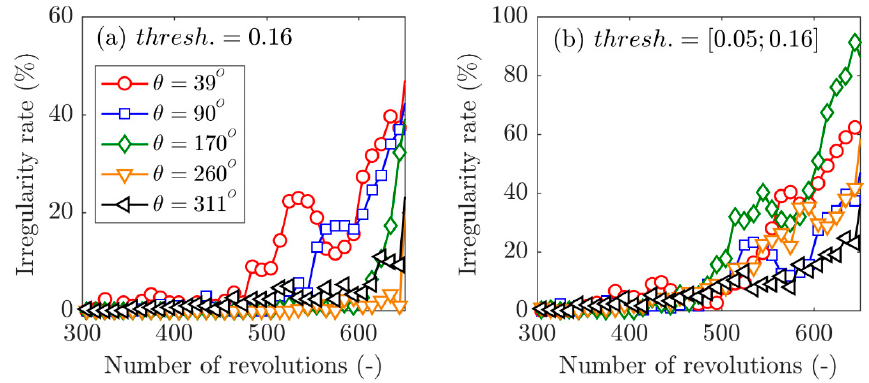
Figure 14. ( a ) irregularity rate evolution at five angular positions for a constant threshold and ( b ) optimized thresholds depending on the sensor location. x = 0.55C x , moderate throttling speed.